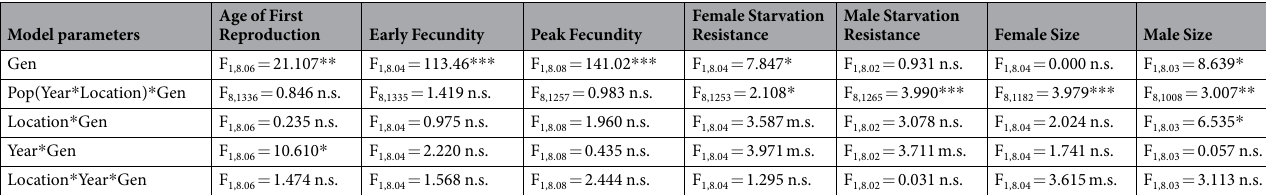
Table 2. Analyses of differences in evolutionary rate in phenotypic traits (ANCOVA) across generations. Note: significance levels: p > 0.1 n.s.; 0.1 > p > 0.05 m.s.; 0.05 > * p > 0.01; 0.01 > ** p > 0.001; *** p < 0.001. F statistic values are provided with the indication of degrees of freedom of the effect and error